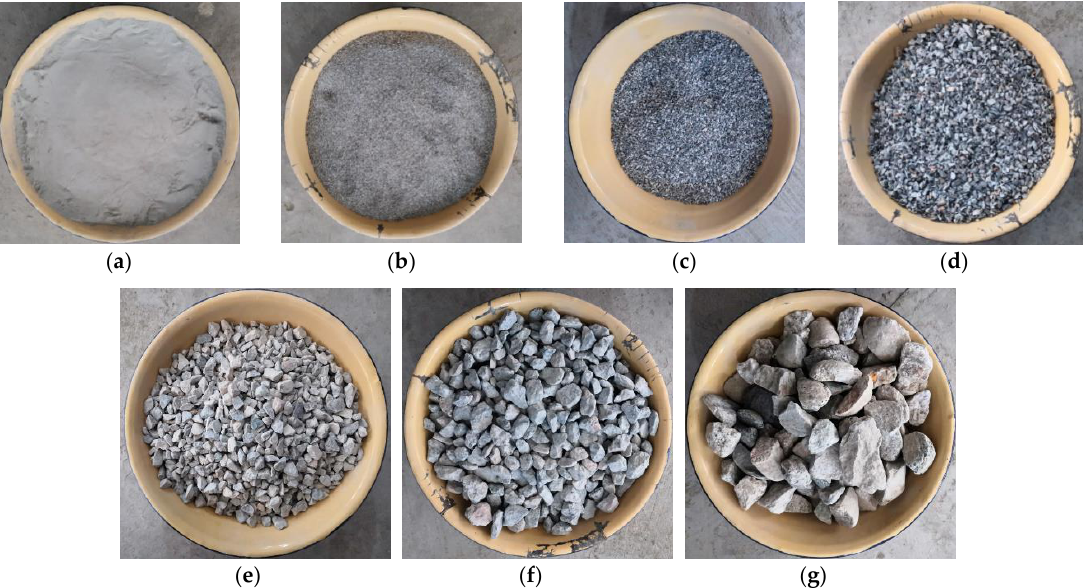
Figure 4. The aggregates screen size: ( a ) 0~0.075 mm, ( b ) 0.075~0.6 mm, ( c ) 0.6~2.36 mm, ( d ) 2.36~4.75 mm, ( e ) 4.75~9.5 mm, ( f ) 9.5~19 mm, ( g ) 19~31.5 Table 4. Percent passing of aggregates.